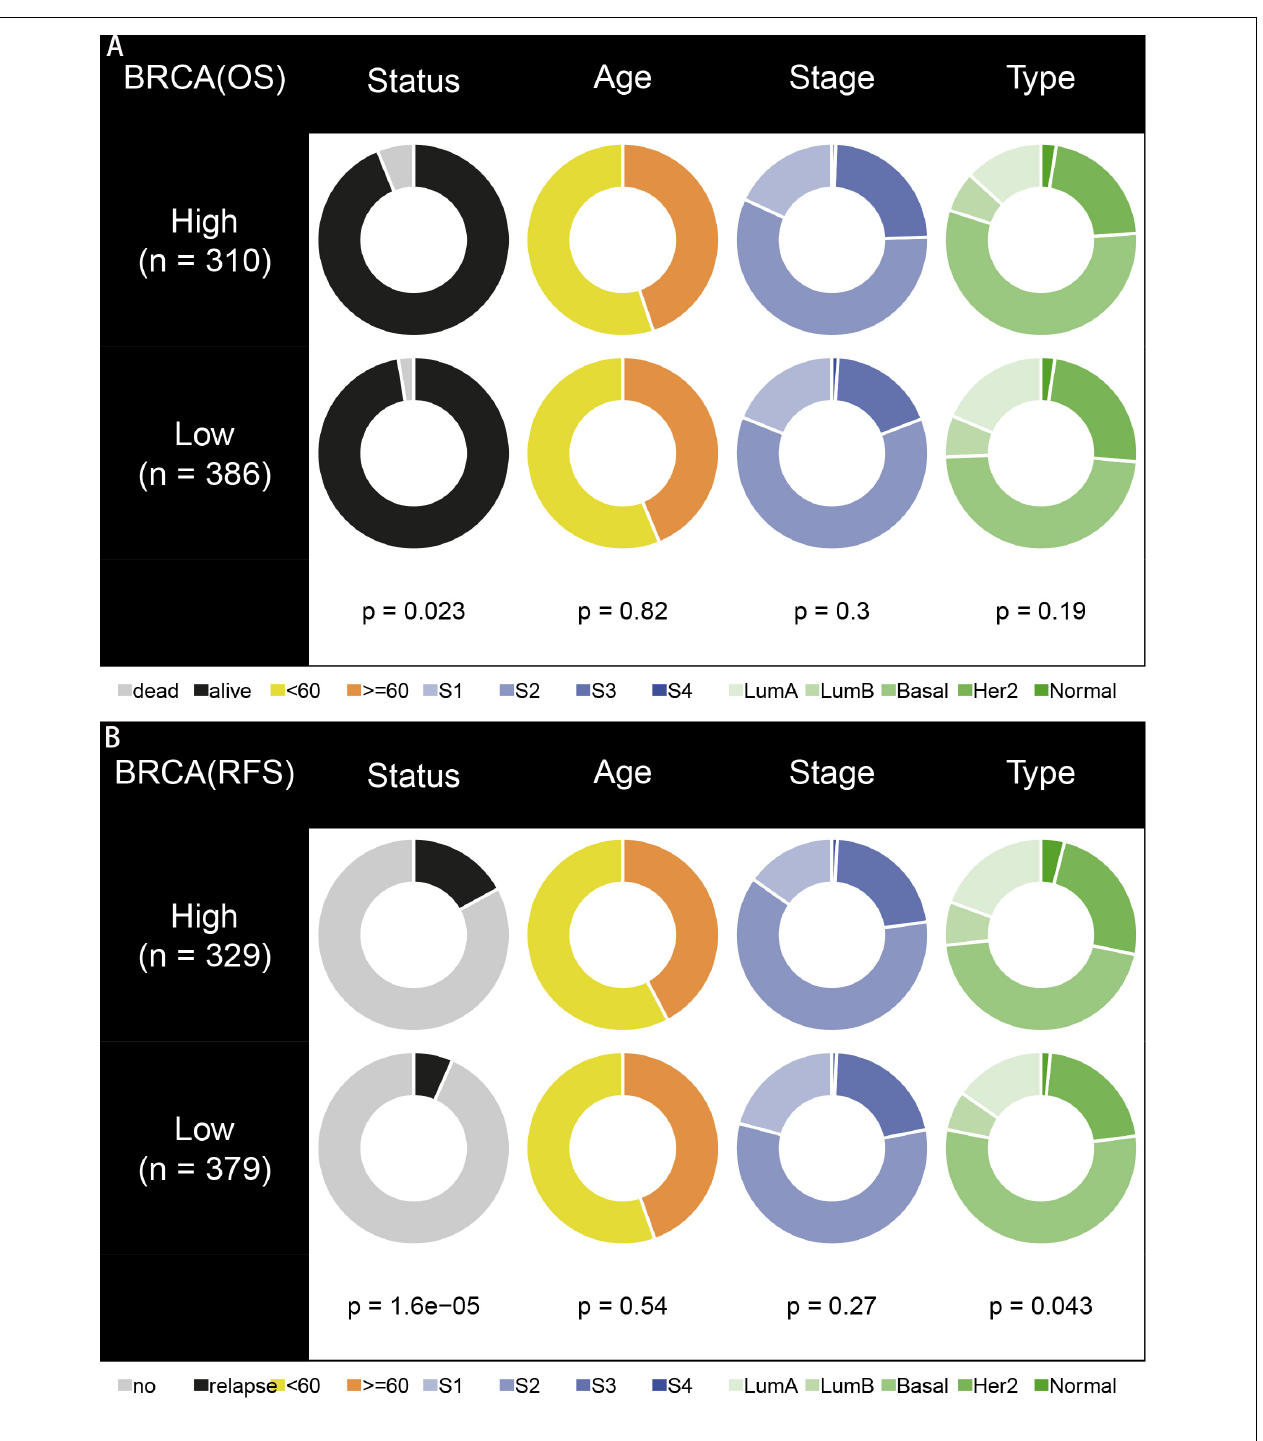
FIGURE 7 | Correlation analysis of signatures with clinicopathological characteristics in the whole set. (A,B) Pie charts showing Chi-squared test of clinicopathologic factors for OS and RFS in different groups.